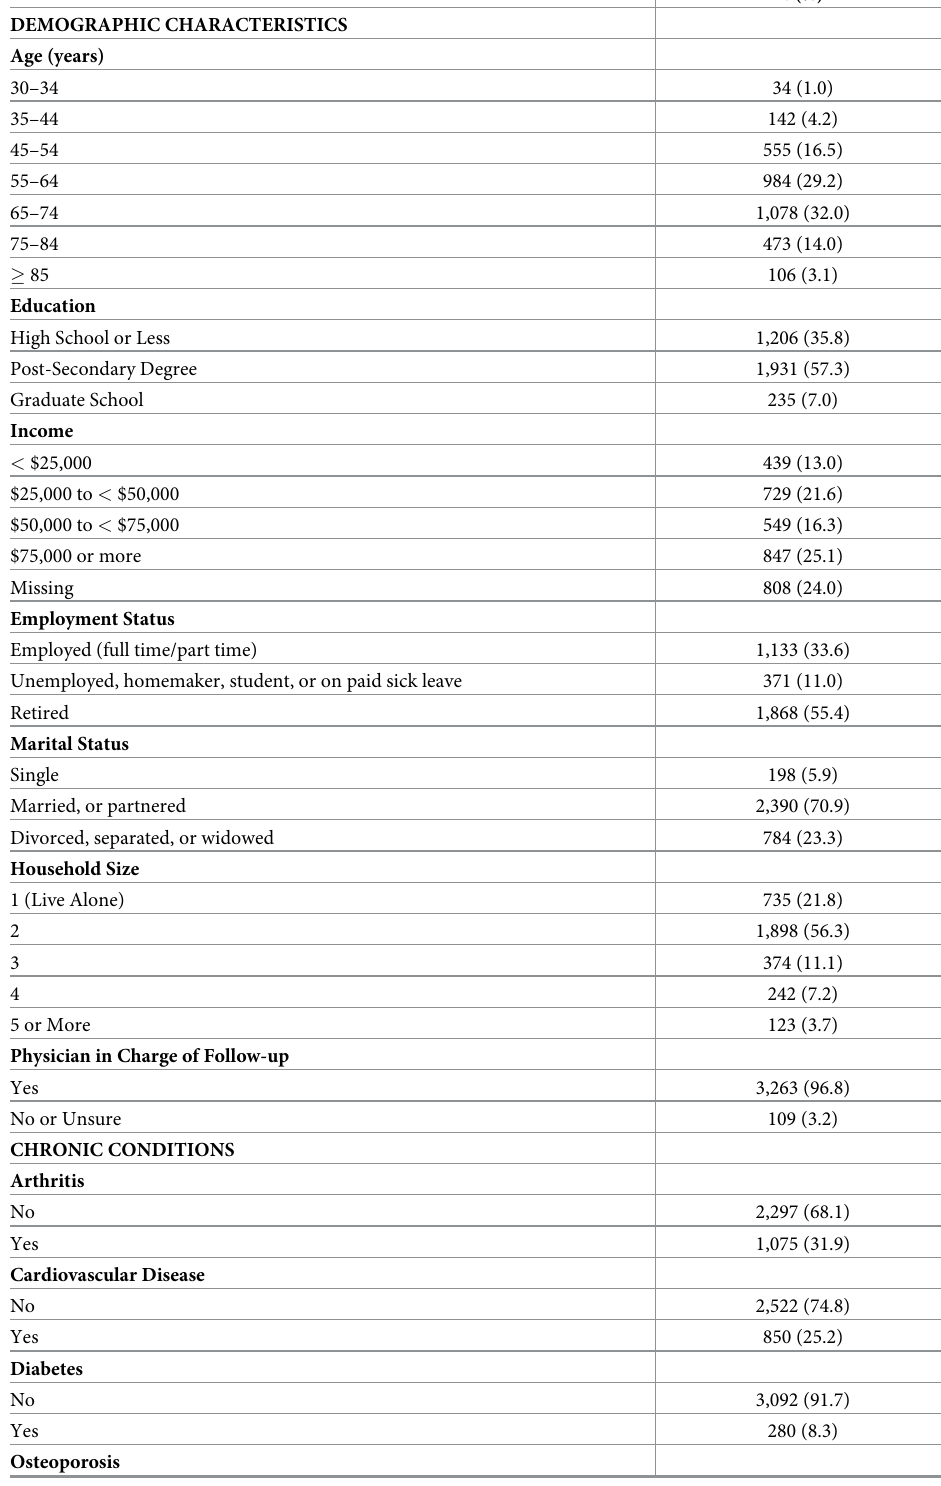
Table 1. Demographic characteristics of the breast cancer survivors in the Transitions Study, N =